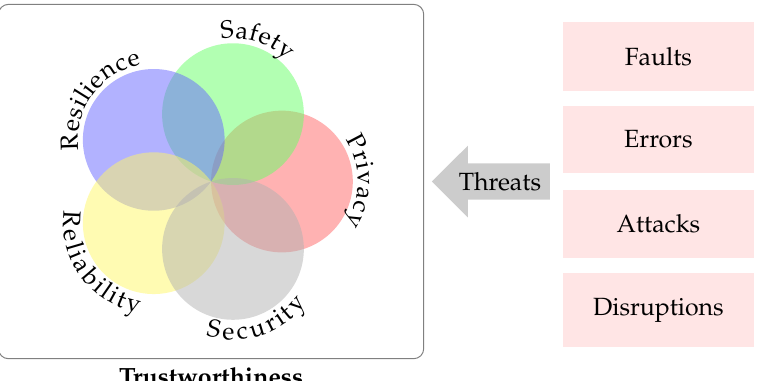
Figure 3. Trustworthiness of an IIoT System as specified by the Industrial IoT Consortium [20]. The key characteristics of the trustworthy IoT system are security, privacy, reliability, safety and